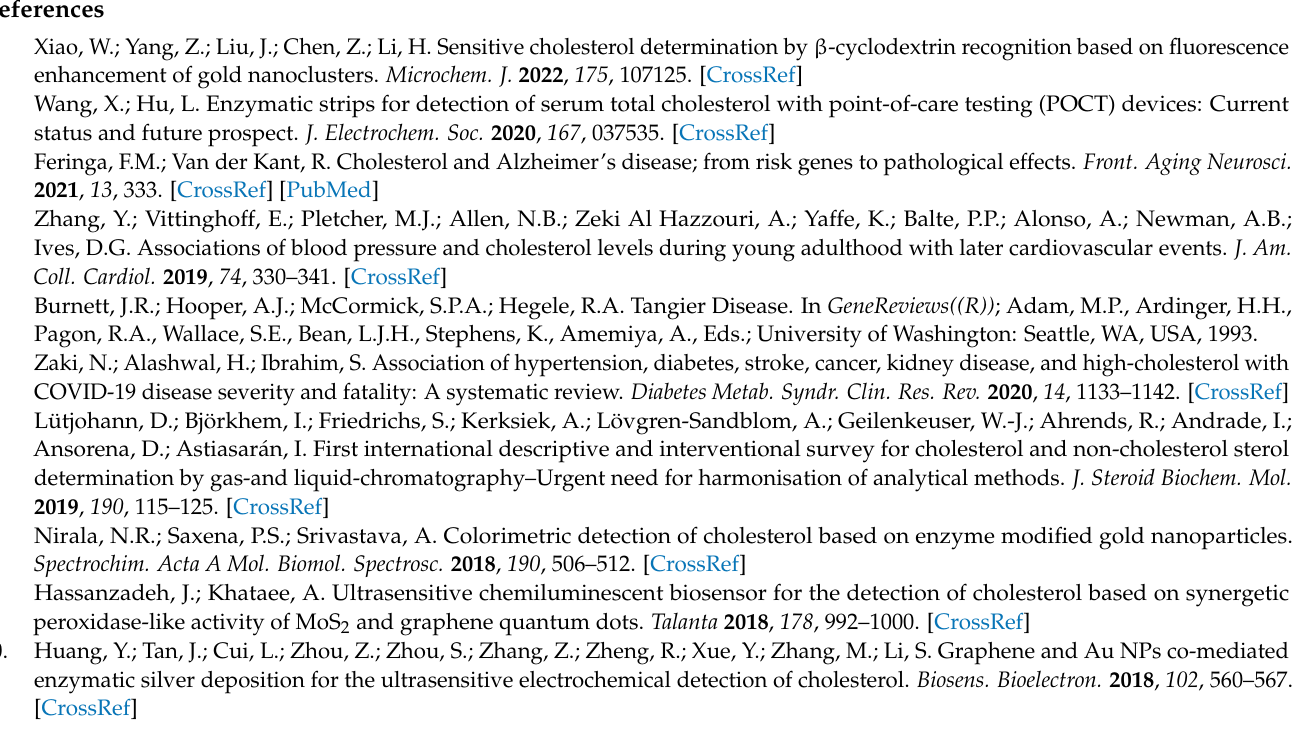
tangents created in the graph; Figure S7. MALDI-MS spectra of (A) BSA (B) GSH 6 /BSA-Au 25 NCs; Figure S8. (A) TEM image of GSH/BSA-AuNCs. (B) The particle size distribution histogram of GSH/BSA-AuNCs. (C) Stability test of GSH/BSA-AuNCs; Figure S9. Fluorescence response of the GSH/BSA-AuNCs ( λ ex = 320 nm; λ em = 670 nm) in presence of 200 µ M H 2 O 2 at different pH (A), incubation temperature (B) and incubation time (C); Figure S10. The selectivity and interference of the sensing system. Fluorescence response of GSH/BSA-AuNCs@VCDs ratio in the presence of 100 µ M of different substances before (black) and after (red) addition of cholesterol (100 µ M); Figure S11. (A) Fluorescence decay of the GSH/BSA-AuNCs as a function of time with different concentrations of H 2 O 2 . (B) Simultaneous monitoring of the fluorescence kinetics of (i) Amplex Red ( λ ex = 560 nm; λ em = 590 nm) and (ii) GSH/BSA-AuNCs ( λ ex = 320 nm; λ em = 670 nm) signal at series of H concentrations. Reactions were carried out in 10 mM sodium phosphate buffer and the concentration of GSH/BSA-AuNCs and Amplex Red was 1 µ M and 20 µ M, respectively. (C) Kinetic curves of I 590 ( λ ex = 560 nm) for monitoring the catalytic oxidation of Amplex Red in the presence of 1 µ M BSA at 0–5 mM H 2 O 2 . The reaction media was the same as in (B); Table S1. Comparison of fluorescence nanomaterials and their analytical performance for cholesterol detection. References [56–60] are cited in the supplementary